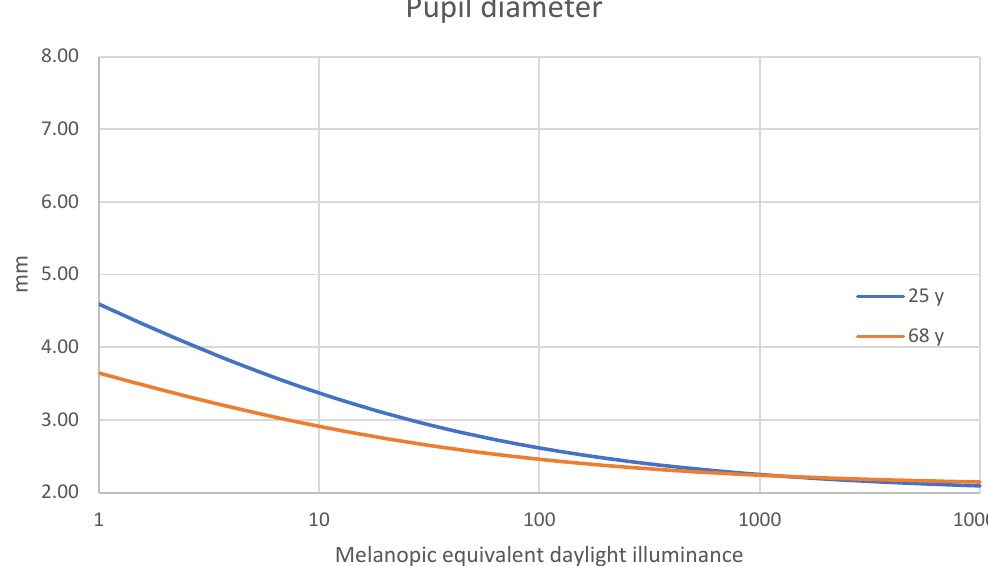
Figure A3. Pupil diameter for ages of 24.5 and 68 year according to the Watson and Yellott simplified unified formula.